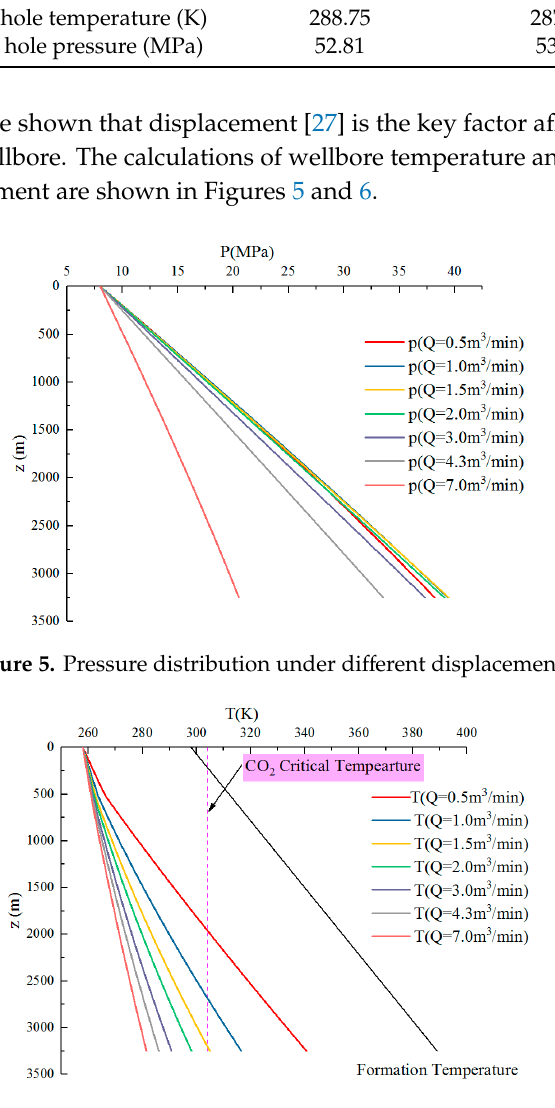
Figure 7. Bottom hole pressure and temperature under different displacement. Figure 8. CO 2 phase distribution in the wellbore. 4.2. CO 2 Phase State and Physical Properties Distribution Because of the large difference between the injected fluid and geothermal temperature during CO 2 fracturing, CO 2 would absorb heat and might undergo phase change as approaching the bottom hole. A pressure–enthalpy diagram is adopted to analyze the phase transition process in the wellbore for CO 2 fracturing, as presented in Figure 8. During the flow process from the wellhead to the bottom hole, CO 2 transforms from liquid state into supercritical state under lower displacement, while it